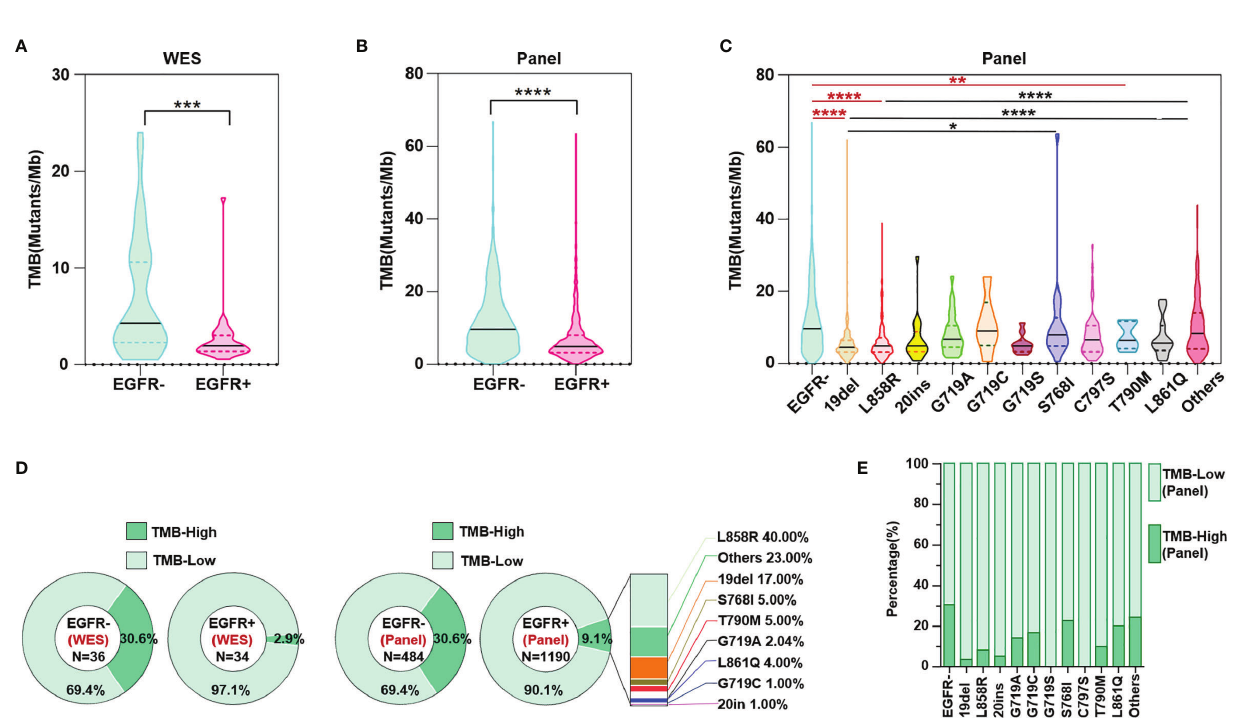
FIGURE 2 | TMB level evaluated both through WES and panel sequencing. (A) WES calculated TMB level in NSCLC patients with and without EGFR mutation. (B) Panel sequencing calculated TMB level in NSCLC patients with and without EGFR mutation. (C) Panel sequencing calculated TMB level in NSCLC patients of different EGFR mutation subtypes. (D) Ratio of TMB high or low evaluated by WES and panel sequencing. (E) Ratio of TMB high or low evaluated by panel sequencing in different subtypes of EGFR mutation. *means p < 0.05, **means p < 0.01, ***means p < 0.001, ****means p <